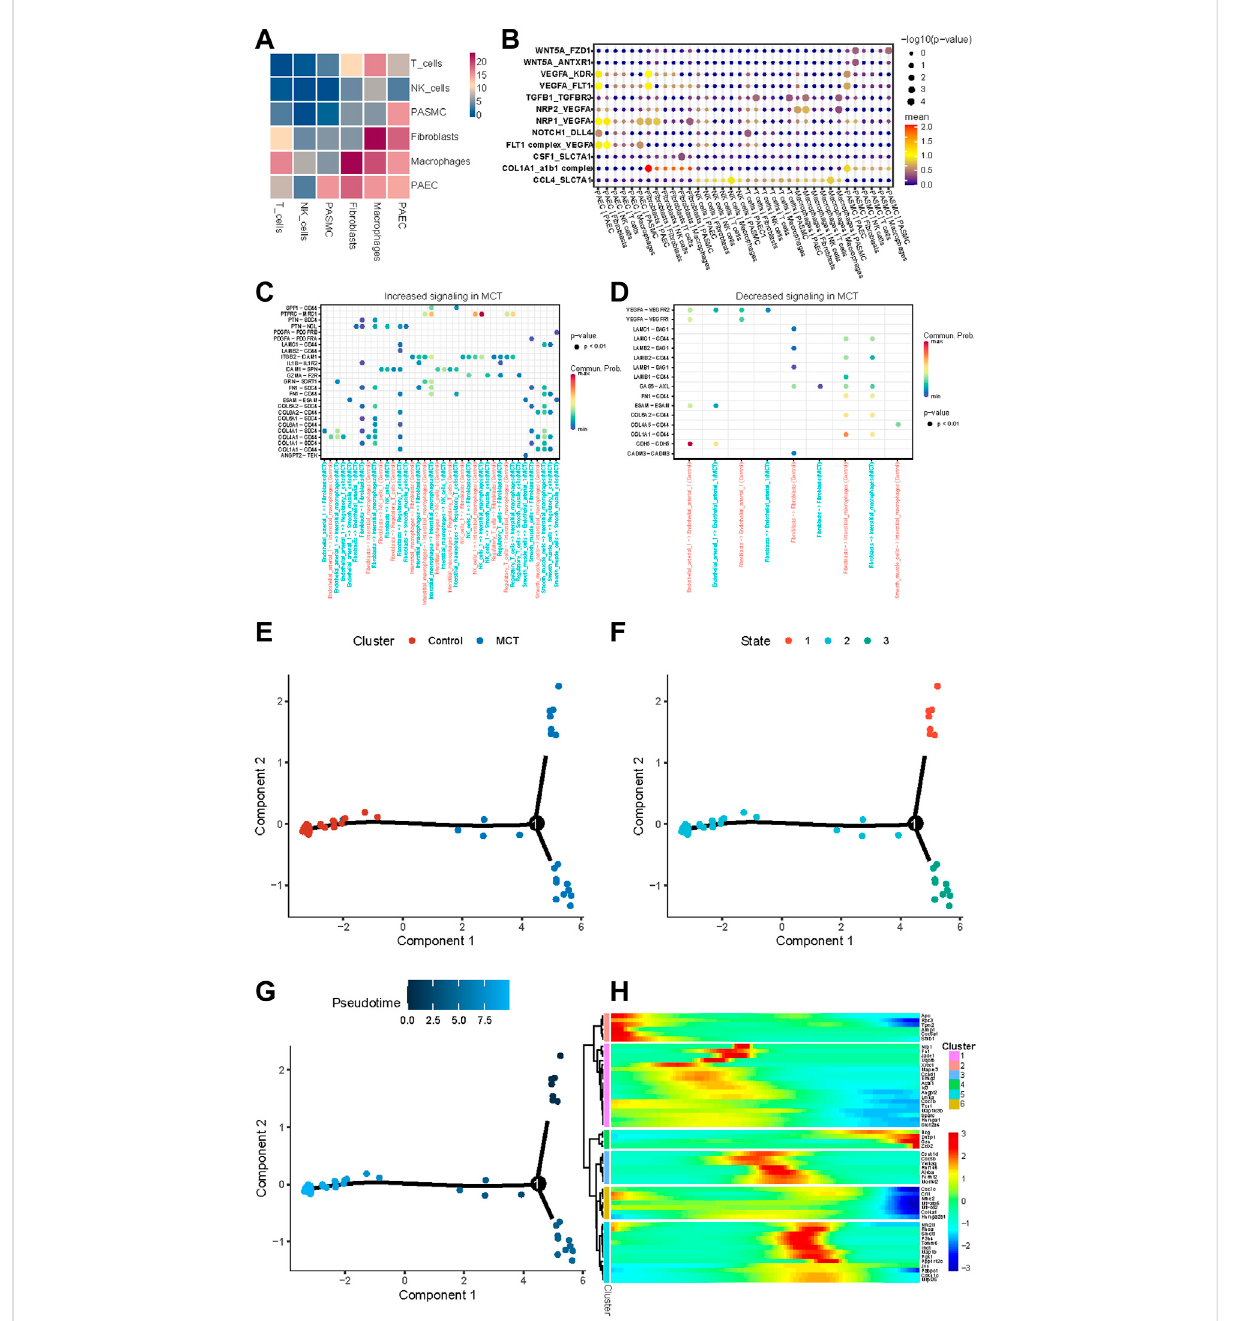
FIGURE 6 Results for the assessment of cell – cell Interactions in MCT-PAH and the pseudo-time trajectory analysis conducted with smooth muscle cells. (A) The cell – cell interactions in MCT-PAH involved 6 cell types. (B) The ligand – receptor pairs are presented. The cell type labels are designated as (the cell type expressing the ligand) — (the cell type expressing the receptor). The ligand-receptor pairs were regulated by HNRNPA2B1. (C,D) Increasing signaling and decreasing signaling in MCT are presented. (E – G) Pseudo-time trajectory analysis were performed in SMCs (cluster, state and Pseudo-time). (H) The gene expression revealed in the pseudo-chronological analysis conducted with